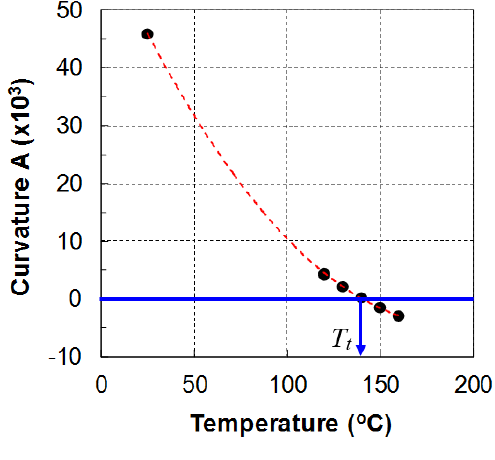
Figure 19. Determination of the twin-slip transition